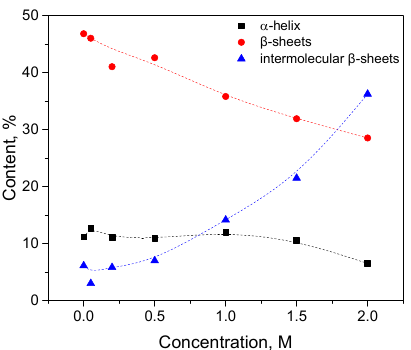
Figure 5. Potassium thiocyanate-induced conformational transition of trypsin at 23 °C. Protein concentration was 20% wt.